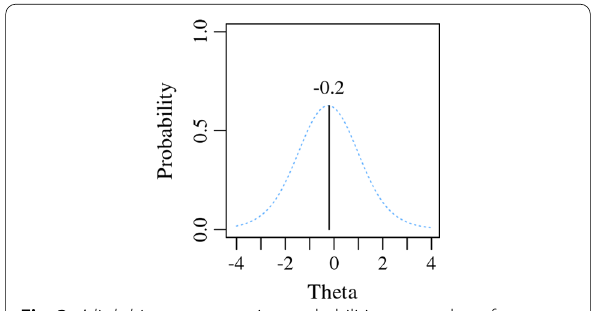
Fig. 3 A little bit response option probabilities across theta for PROMIS Fatigue item